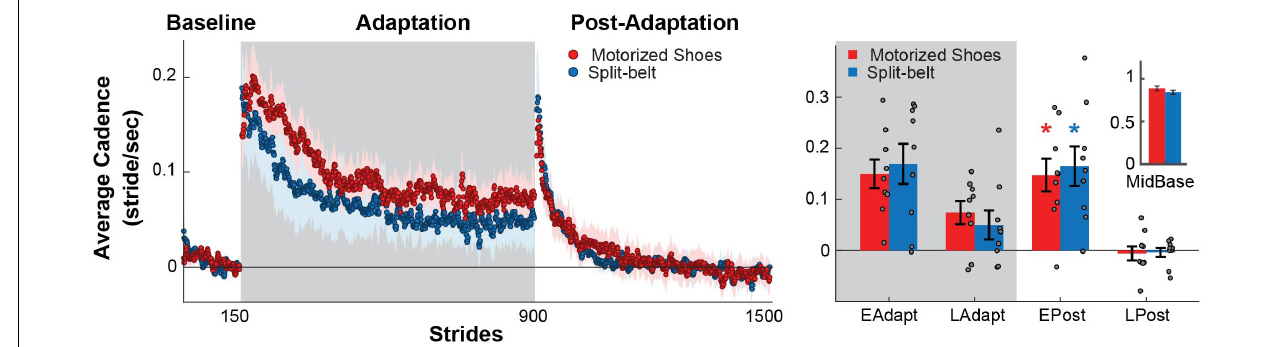
FIGURE 5 | Modulation of cadence. (Left) Time courses during medium baseline, adaptation, and post-adaptation for the average cadence is shown for each group. Shaded gray area represents the adaptation period when the feet move at different speeds (“split” walking), whereas white areas represent when the feet move at the same speed. Colored dots represent the group average of five consecutive strides and colored shaded regions indicate the standard error for each group (motorized shoes: red; split-belt: blue). (Right) Bar plots indicate the mean ± standard errors for cadence for each group and epoch of interest. Note that the values were corrected for baseline biases (i.e. MidBase). Colored asterisks over the bars indicate significant after-effects (i.e. early post-adaptation is significantly different from baseline; p < 0.05) for each of the groups (motorized shoes: red; split-belt: blue). The small bar plot on the right indicates the mean ± standard errors for the Cadence for each group during medium